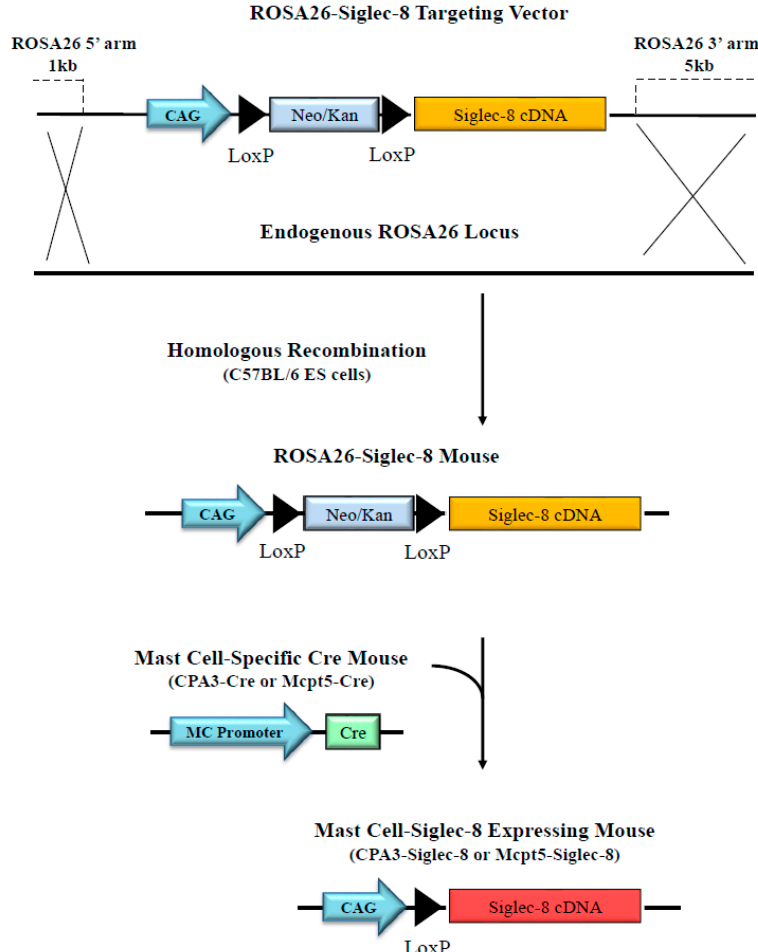
Figure 1. Targeted expression of human Siglec-8 into mouse mast cells. Schematic overview of the generation of conditional knock-in mice that express human Siglec-8 on mast cells. A ROSA26-DEST vector-based targeting construct was generated that contains the CAG promoter, LoxP-floxed-Neo/Kan as a STOP fragment followed by human Siglec-8 cDNA. Using standard procedures, ROSA26-CAG-STOP-Siglec-8 (or simply ROSA26-Siglec-8) knock-in mice were generated. After cross-breeding to mast cell specific Cre mouse lines (CPA3-Cre and Mcpt5-Cre), Cre-mediated removal of the conditional Neo-STOP fragment led to CAG promoter driven human Siglec-8 expression on mast cells. Terms used are CAG: CAG promoter (a combined fusion of CMV enhancer, chicken beta-Actin promoter and rabbit beta-Globin splice acceptor site); Neo/Kan: Neomycin/Kanamycin resistant gene; LoxP: LoxP recognition sequences.